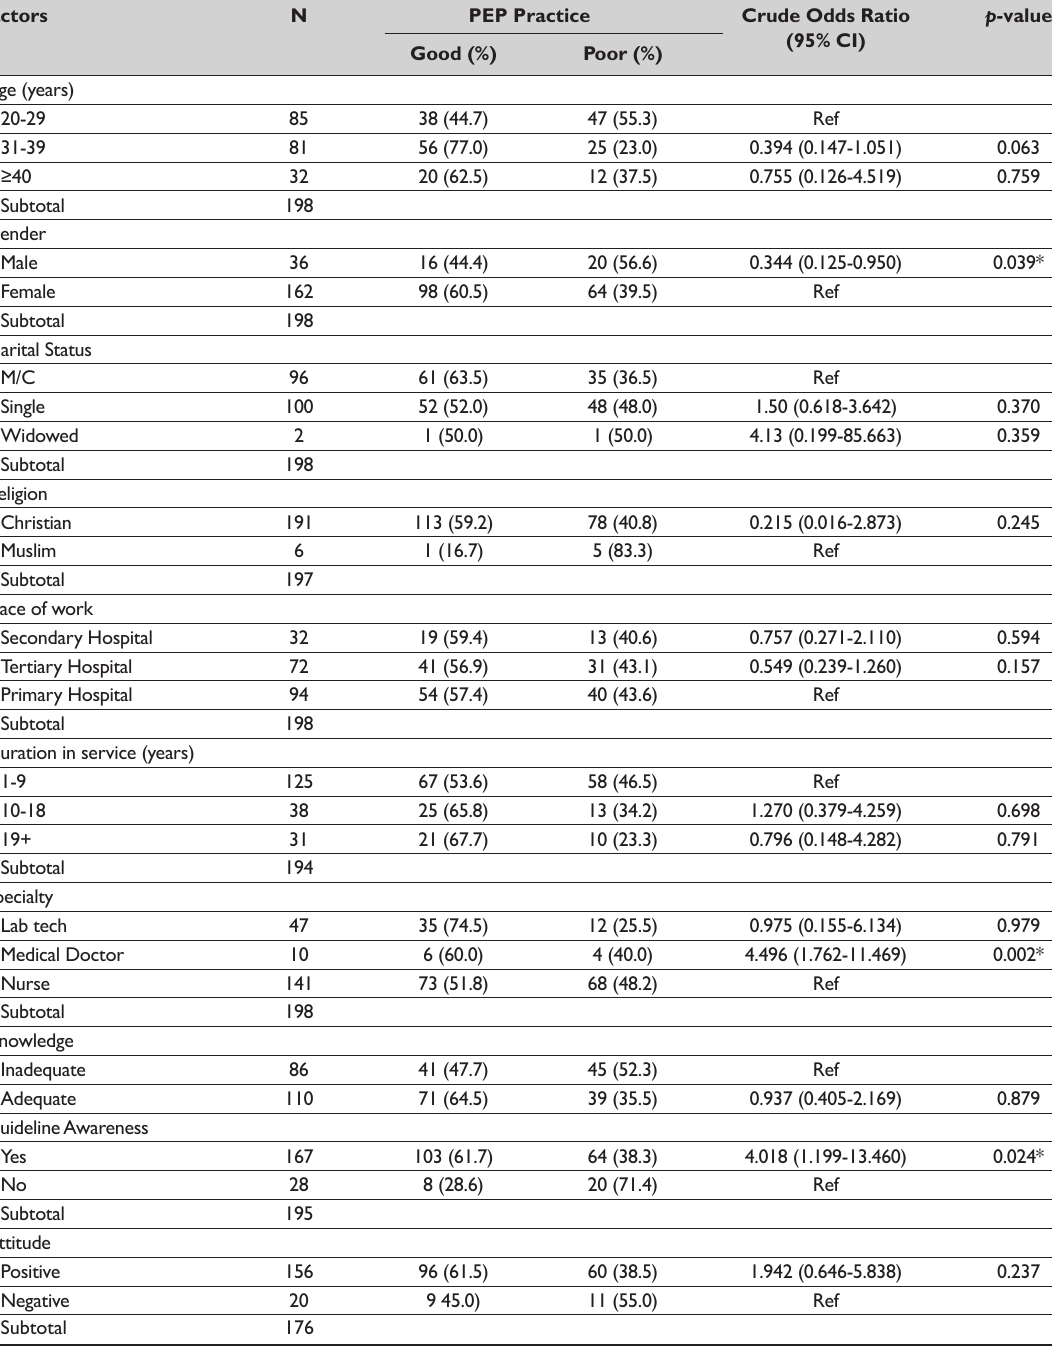
Table 3: Factors that influence compliance with HIV Post Exposure Prophylaxis (PEP)